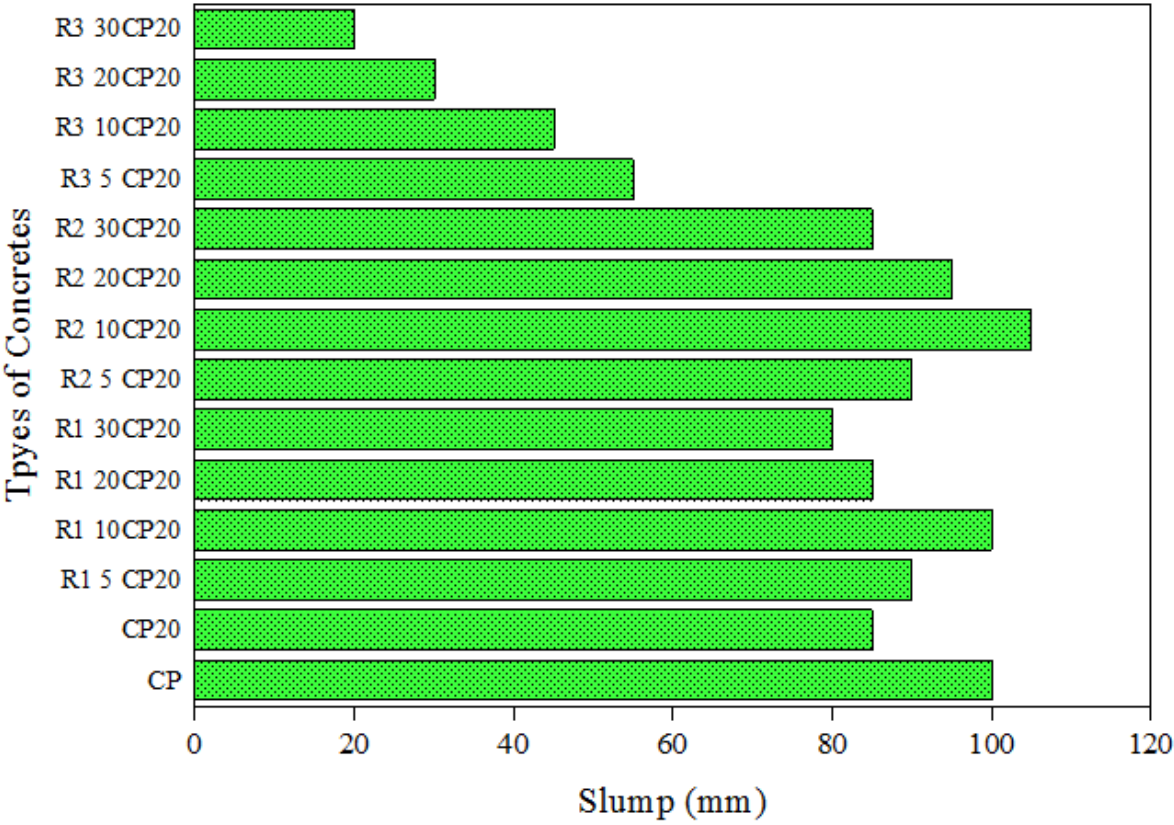
Figure 5. Slump values of concrete with different types and concentrations of TRAs.